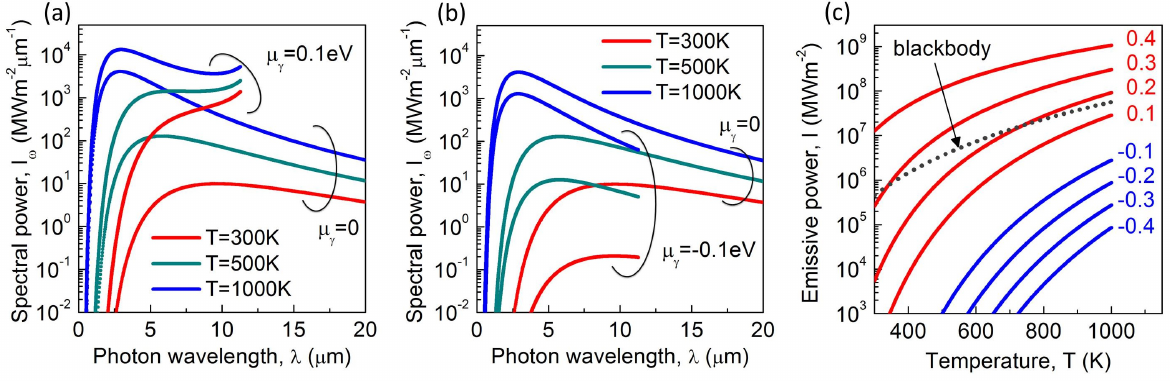
Fig. 1. Chemical potential of light. (a, b) Heat flux spectra as a function of wavelength and temperature for pure thermal emitters ( µ γ = 0) and luminescent emitters with a photon chemical potential µ γ = 0.1 eV (a) and µ γ = −0.1 eV (b). The emission cut-off energy (defined by the material bandgap) is 0.11 eV in both cases. (c) Stefan-Boltzmann law for photons emitted with a chemical potential: emissive power as a function of temperature and chemical potential ( µ γ values are shown as labels). The Stefan-Boltzmann law for a blackbody emitter is shown as a gray dotted line for